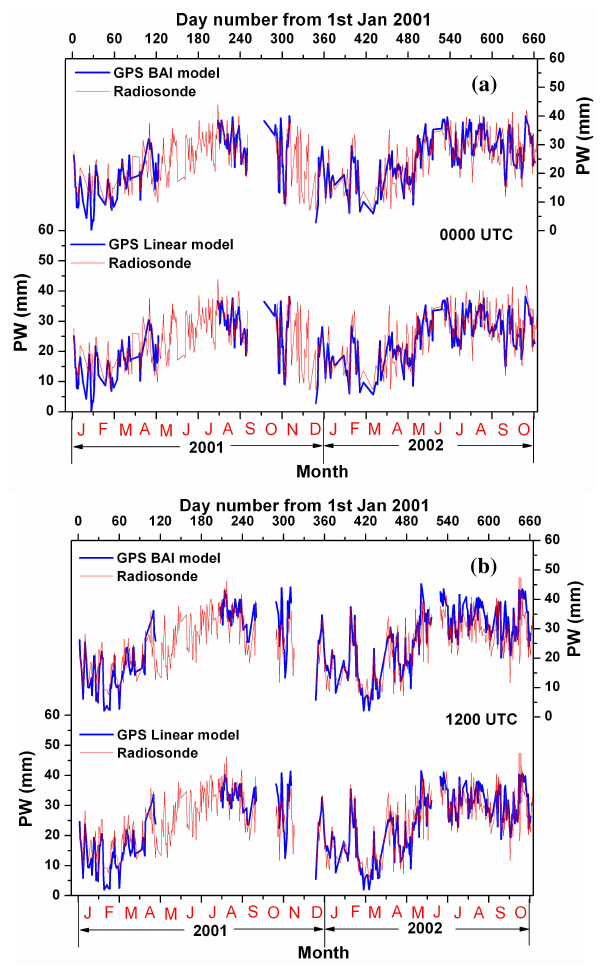
Fig. 6. Daily precipitable water estimated from GPS data for Banga- lore using BAI regional model and site-specific linear model along with those derived from radiosonde data at 00:00 UTC (a) and 12:00 UTC (b) for the period January 2001 to October 2002.